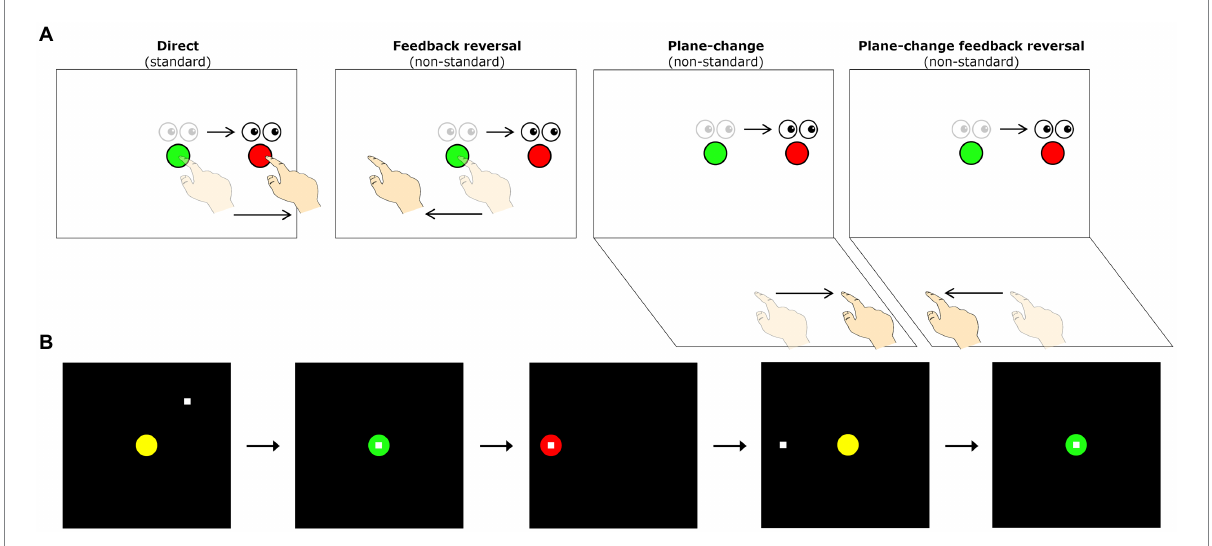
FIGURE 1 (A) Schematic drawing of the visuomotor task conditions. Lighter eye and hand symbols denote the starting position for each trial (green central target). Darker eye and hand symbols denote the instructed eye and hand movements for each task. Red circles denote the peripheral (reach) target, presented randomly in one of four locations (left, up, right, or down relative to the central target). The direct interaction task requires standard mapping, where participants slide their finger on a touch screen to move a cursor from a central target to one of four peripheral targets. The other three conditions involve non-standard visuomotor integration, where targets either have a 180 ° feedback reversal (feedback reversal), are spatially dissociated from the plane of hand motion (plane-change), or both (plane-change + feedback reversal). (B) Sequence of events during one trial of the visuomotor task. All trials begin in the central (home) target. Once the participant moves the cursor (denoted by the white square) into the central target, the target changes from yellow to green to signify a movement preparation period. After 4,000 ms, a red peripheral target appears in one of four directions (up, down, left, or right of the center) and serves as the ‘Go’ signal. Once the peripheral target is acquired and held for 500 ms it disappears, signaling the end of the trial. After an inter-trial interval of 2000 ms, the central yellow target reappears, and the participant moves back to the central target to initiate the next